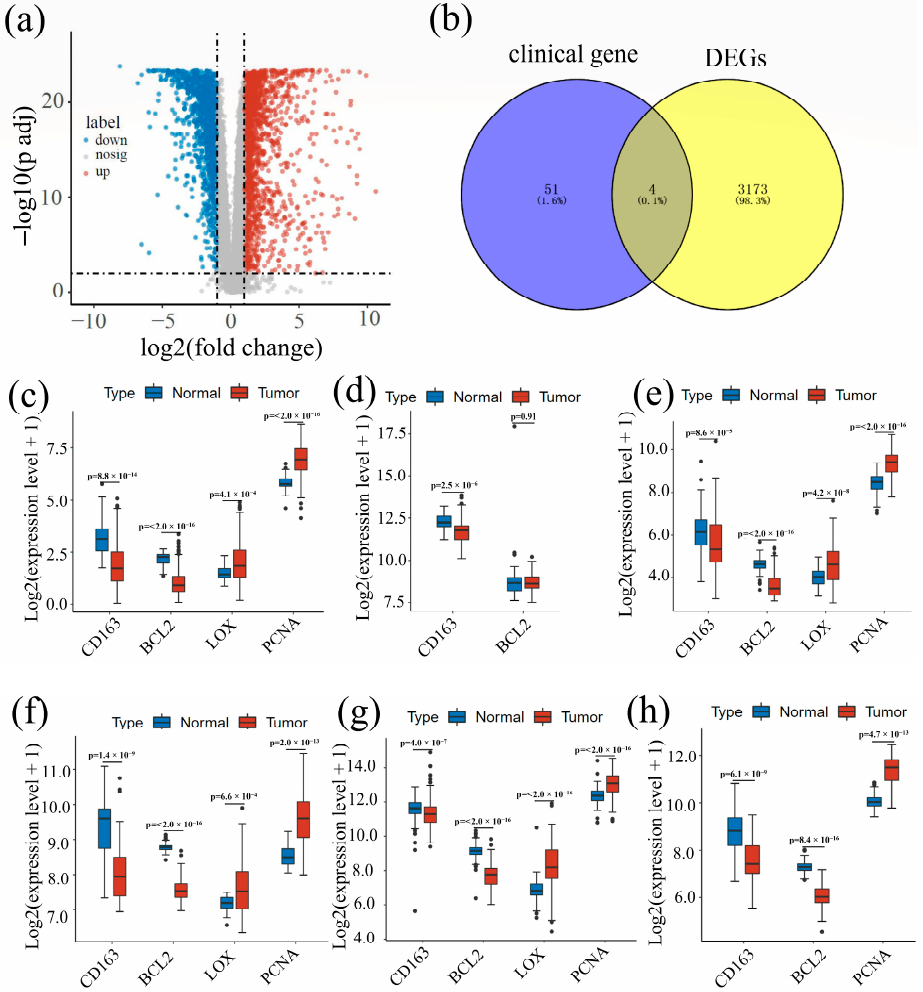
Figure 3. ( a ) Volcano plot of all differentially expressed genes in TCGA; red means up-regulation, blue means down-regulation, and gray means interferential genes. ( b ) Venn diagram for the inter- section between genes from TCGA database after difference analysis (yellow part) and genes rec- orded in hospital database (blue part). ( c – h ) Box plots of intersectional gene expressions. Based on